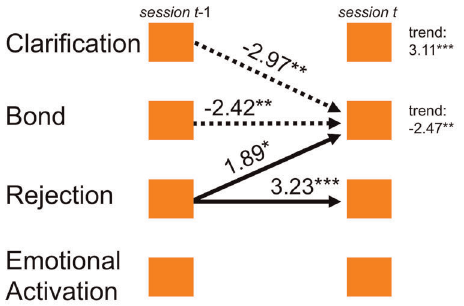
Figure 2. Process model of the time series in Figure 1. Process model of the time series illustrated in Figure 1. Arrows indicate significant time-lagged associations between components identified by vector autoregression analysis. Parameter values are printed next to respective arrows (*, p , .05; **, p , .01; ***, p , .001), significant linear trends are printed right. Negative associations have dotted arrows.